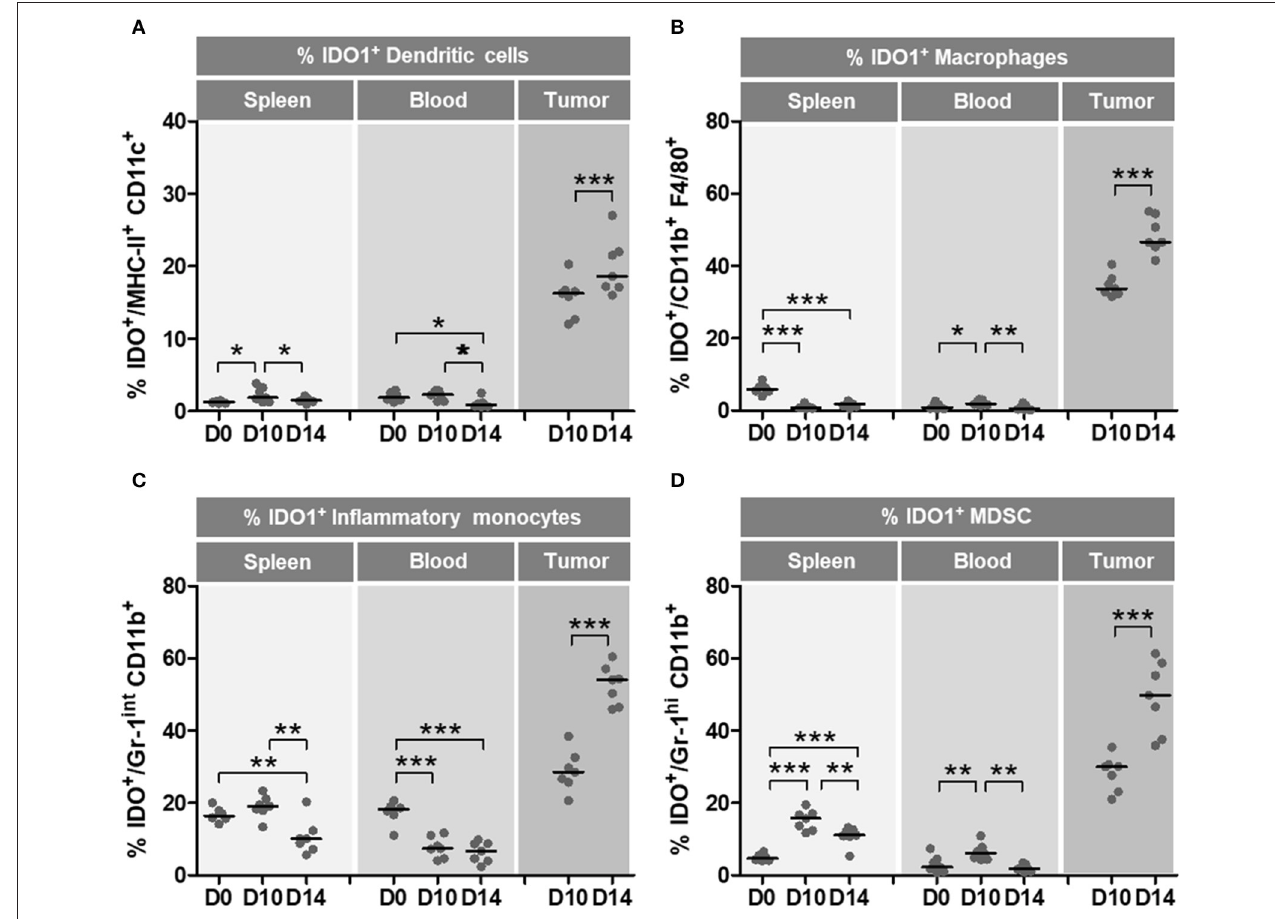
FIGURE 2 | Immune microenvironment cells increase IDO1 expression during oncogenesis. Wild-type (WT) C57BL/6 mice ( n = 7) were subcutaneously injected with 1 × 10 5 TC-1 cells and tumors were evaluated at 10 and 14 day after the tumor cell transplantation. Naïve mice were used as a reference of physiological parameters. The frequencies of DCs, macrophages, inflammatory monocytes and MDSC were evaluated in spleens, blood and tumor tissues. IDO1 expression was measured by intracellular staining and flow cytometry analyses. (A–D) Frequency of IDO1-expressing immune cells at 0 day (D0–naïve mice), 10 day (D10) and 14 day (D14) after TC-1 transplantation. Parameter used to characterize the different cell populations: (A) DCs (CD45 + , CD11c high , MCH-II high ), (B) macrophages (CD45 + , MCH-II + , CD11b + , F4/80 + ), (C) inflammatory monocytes (CD45 + , CD11b int , Ly6C high , Ly6G − ), (D) MDSC (CD45 + , CD11b high , Ly6C int , Ly6G + ). Data representative of two independently performed experiments. Statistical significance: * p < 0.05, ** p < 0.01, and *** p < 0.001 by